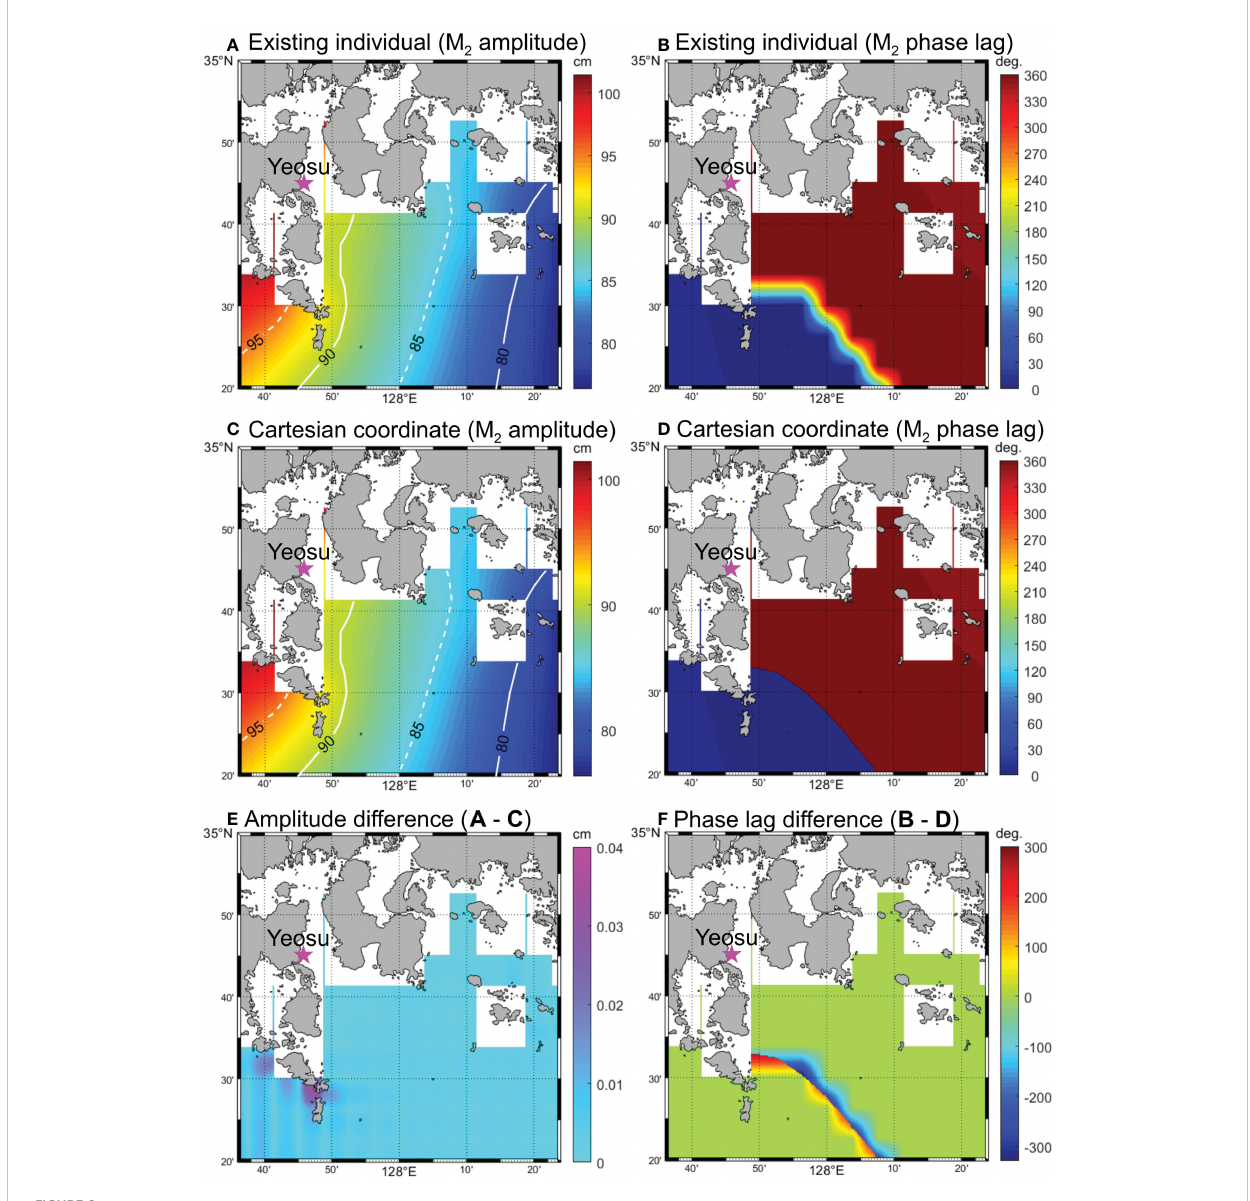
FIGURE 2 M 2 co-amplitude and cotidal charts (A – D) off Yeosu, Korea. The interpolated charts were produced using the existing individual linear interpolation method (A, B) and the Cartesian coordinate based linear interpolation (1/320°) method (C, D) from FES2014 tidal constant data (horizontal resolution of 1/16°). Differences between two interpolated charts (i.e., (A − C) , and (B − D) are shown to highlight the errors introduced using the existing linear interpolation method (E, F) . Phase lags are referenced to Greenwich. The magenta star indicates the location of Yeosu Tidal Station, which is operated by